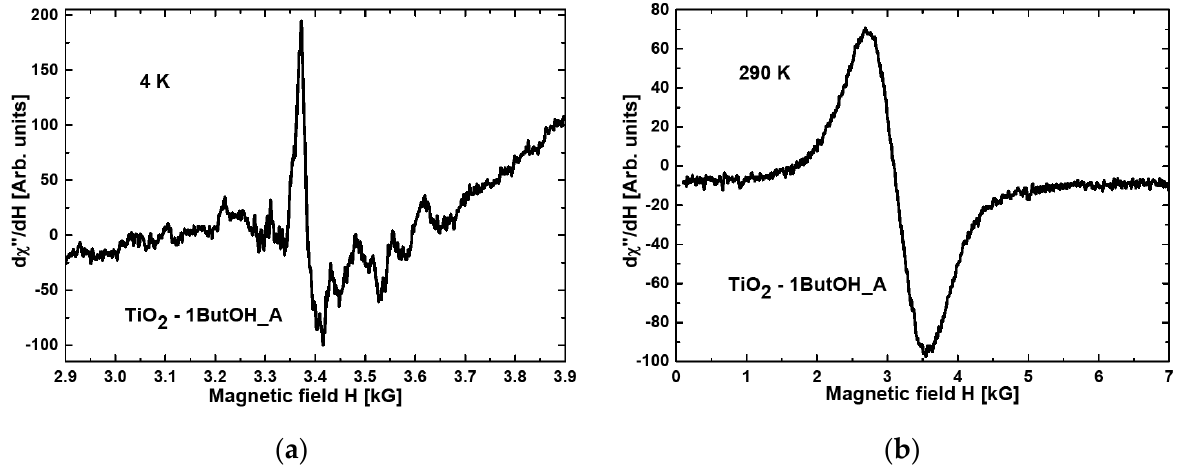
Figure 1. Magnetic resonance spectra obtained at ( a ) 4 K and ( b ) RT for the nanocomposite TiO 2 -1ButOH_A.